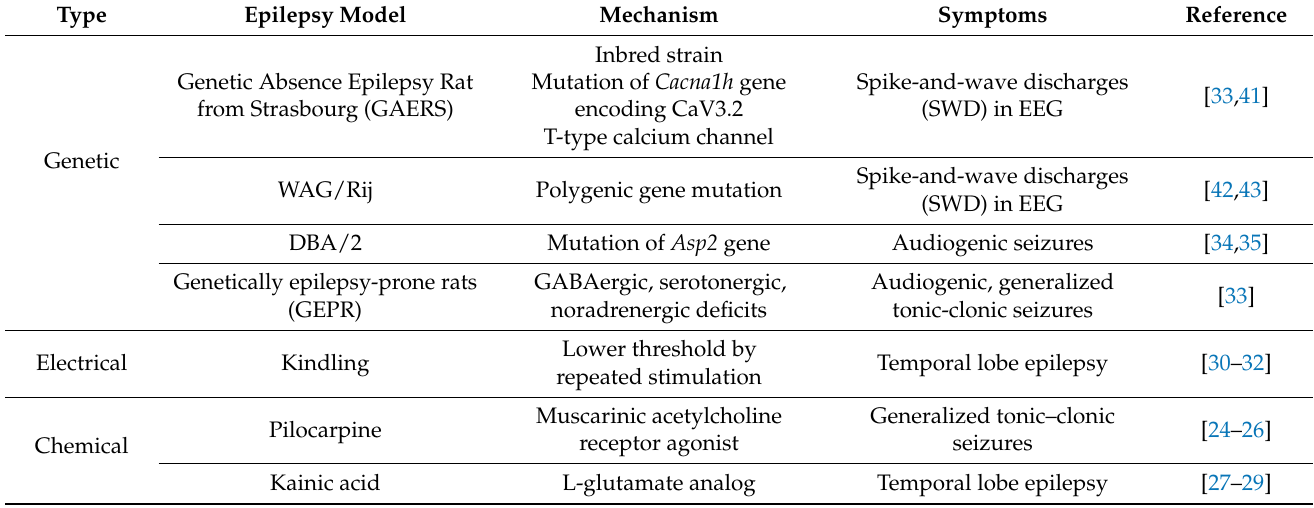
Table 1. The animal models of